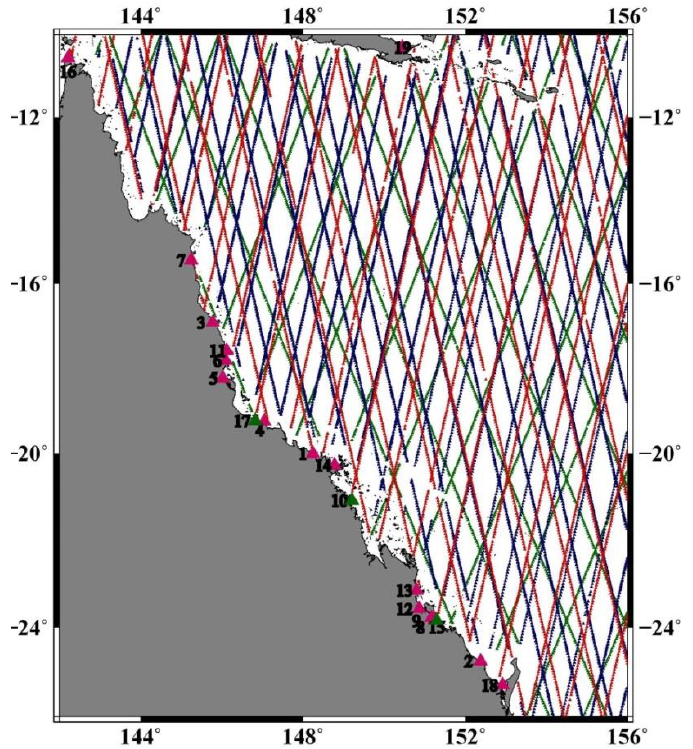
Figure 2. Spatial distribution of altimeter ground tracks and tide gauge locations. Tracks are shown for T/P (in green), ERS-2/Envisat (in blue) and Sentinel-3A (in red), while tide gauges are shown in solid triangles. Of them, Sentinel-3A (in red) and three tide gauges (in green triangles) are used as validation datasets.